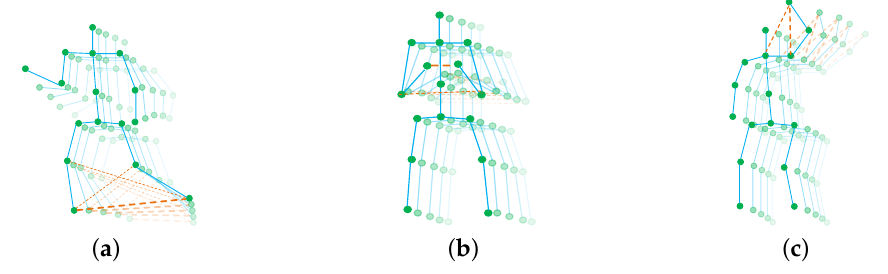
Figure 1. The illustration of action-specific edges. The green circles represent body joints. The blue solid lines represent the structural edges. The orange dashed lines represent the implicit edges. The thickness of lines represents the strength of relationship; ( a ) denotes the action-specific edges of the action running; ( b ) denotes the action-specific edges of the action clapping; ( c ) denotes the action-specific edges of the action waving hand. The action-specific edges are different for various